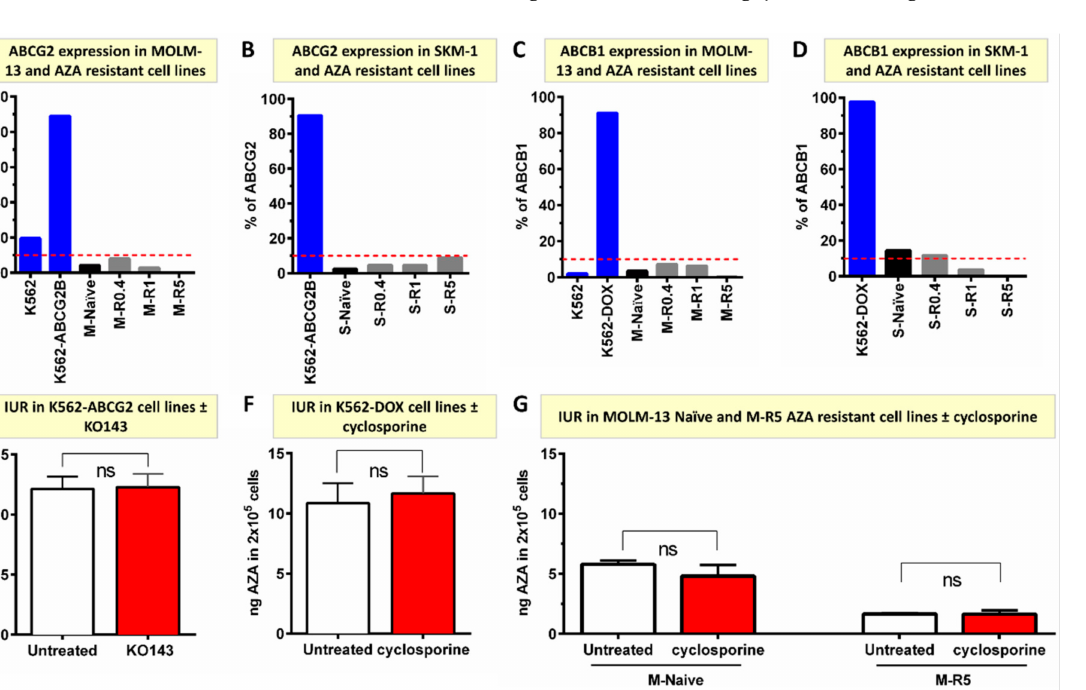
Figure 4. ABCG2 and ABCB1 do not mediate AZA cellular efflux and unlikely contribute to resistance in vitro. ( A , B ) ABCG2 protein is not expressed in MOLM-13- and SKM-1-naïve and AZA-resistant cell lines. ABCG2 over-expressing K562-ABCG2 and ABCG2 negative K562 were used as controls for individual experiments; ( C , D ) ABCB1 is not expressed in MOLM-13-and SKM-1-naïve and AZA- resistant cell lines. ABCB1 over-expressing K562-DOX and ABCB1 negative K562 were used as controls for individual experiments; ( E ) ABCG2 inhibitor (KO143) did not alter 14 C-AZA IUR in K562-ABCG2-overexpressing cells; ( F ) ABCB1 inhibitor (cyclosporine) did not influence 14 C-AZA IUR in K562-DOX cells overexpressing ABCB1; ( G ) cyclosporine did not change 14 C-AZA IUR in MOLM-13-naïve and -resistant cells. Data represent the mean of at least 3 independent experiments. AZA, azacitidine; M, MOLM-13; S, SKM-1; ns, not significant. Similarly, cyclosporine, an ABCB1 inhibitor did not influence the 14 C-AZA IUR in an ABCB1 over-expressing cell line (K562-DOX) (10.84 ± 1.68 ng vs. 11.66 ± 1.42 ng, p = 0.723), MOLM-13-naïve (5.81 ± 0.29 ng vs. 4.80 ± 0.94 ng, p = 0.209) or MOLM-13